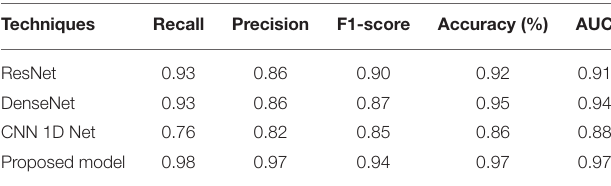
TABLE 4 | Performance comparison with the targeted classification